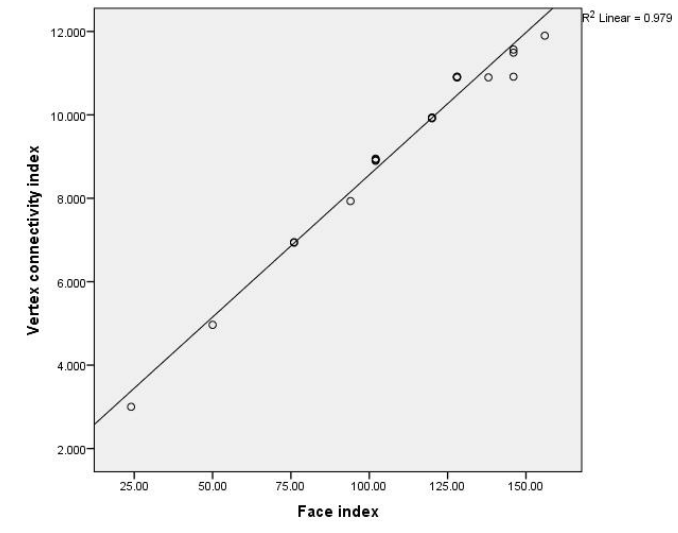
Figure 2. Plot of the face index versus vertex connectivity index for 21 benzenoid hydrocarbons.